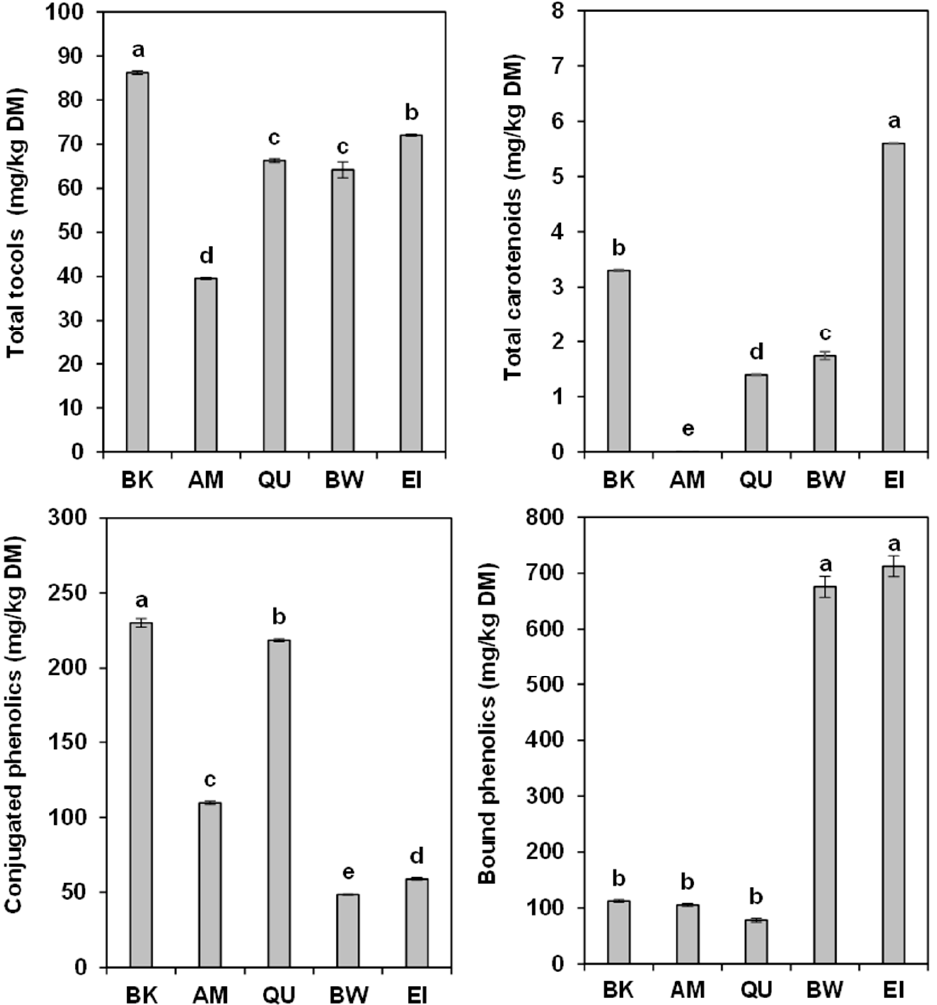
Figure 1. Total tocols, carotenoids, conjugated phenolics and bound phenolics (mg/kg DM) of the buckwheat (BK), amaranth (AM), quinoa (QU), bread wheat (BW) and einkorn (EI) wholemeal. The error bars represent the standard deviation; different letters indicate significant differences ( p < 0.05) among